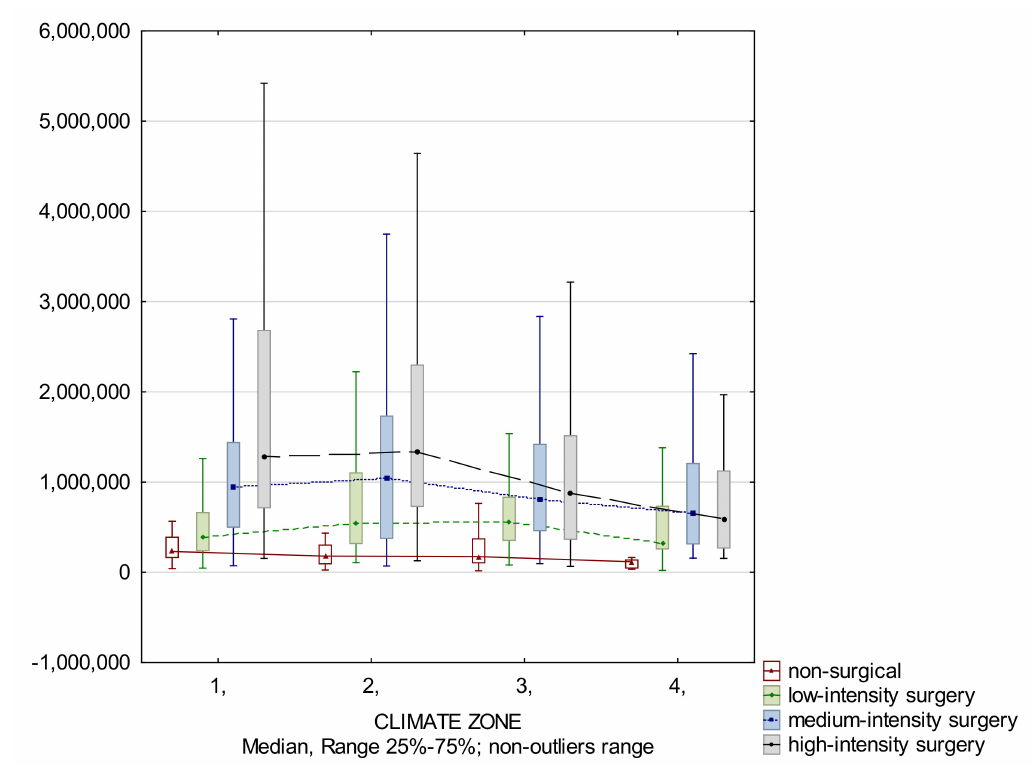
Figure 9. EEC by hospital surgery intensity related to climate zones in Poland.